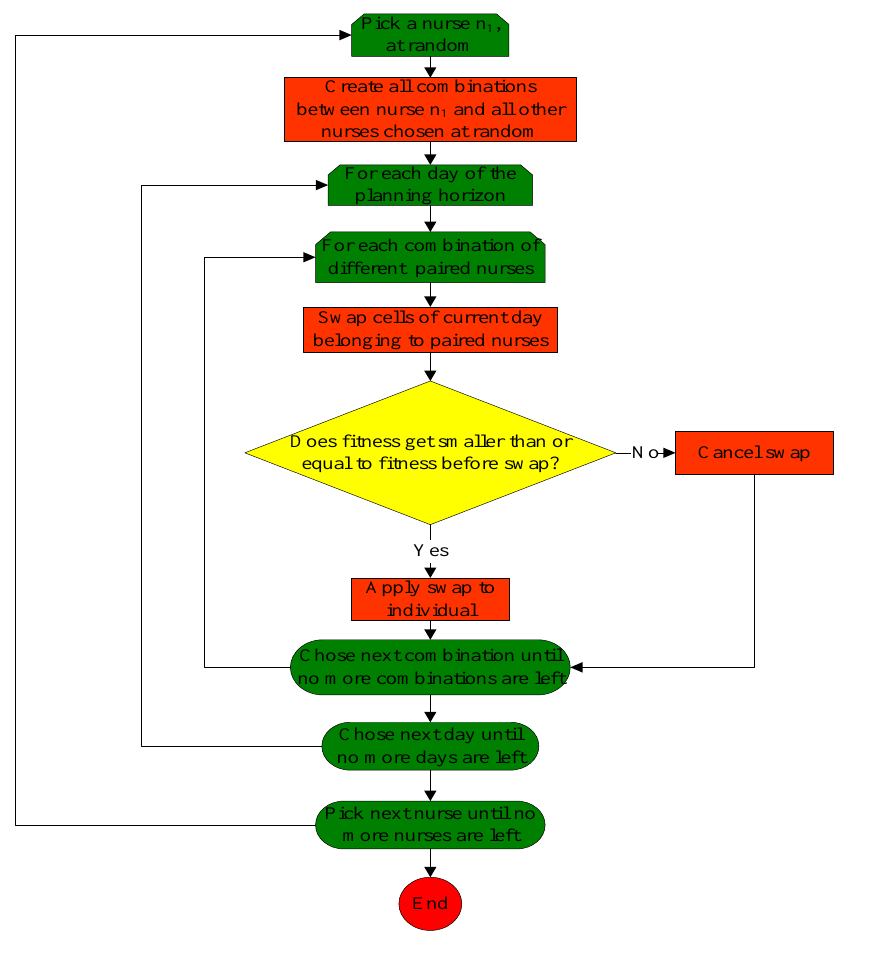
Figure 6. The structure of the procedure, Selective_Day_Swap_Mutation